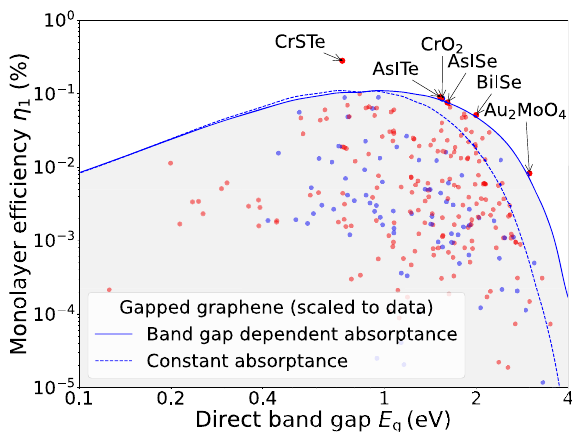
Fig. 6 Band gap dependence of PV ef fi ciencies. Semilogarithmic plot of PV ef fi ciencies vs. direct band gap. The curves represent the ef fi ciency of gapped graphene as calculated by Eq. (17), including a fi nite line width of 50 meV. The color of the dots differentiate between polar (red) and non-polar (blue) compounds, respectively.